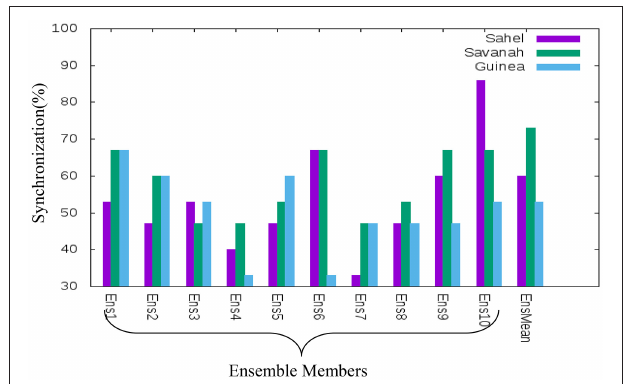
FIGURE 8 | Synchronization (%) of the simulated inter-annual rainfall anomalies between the Ensemble members and the Ensemble mean with reference to observation over the climatological zones of Nigeria (GoG, Savannah and Sahel).